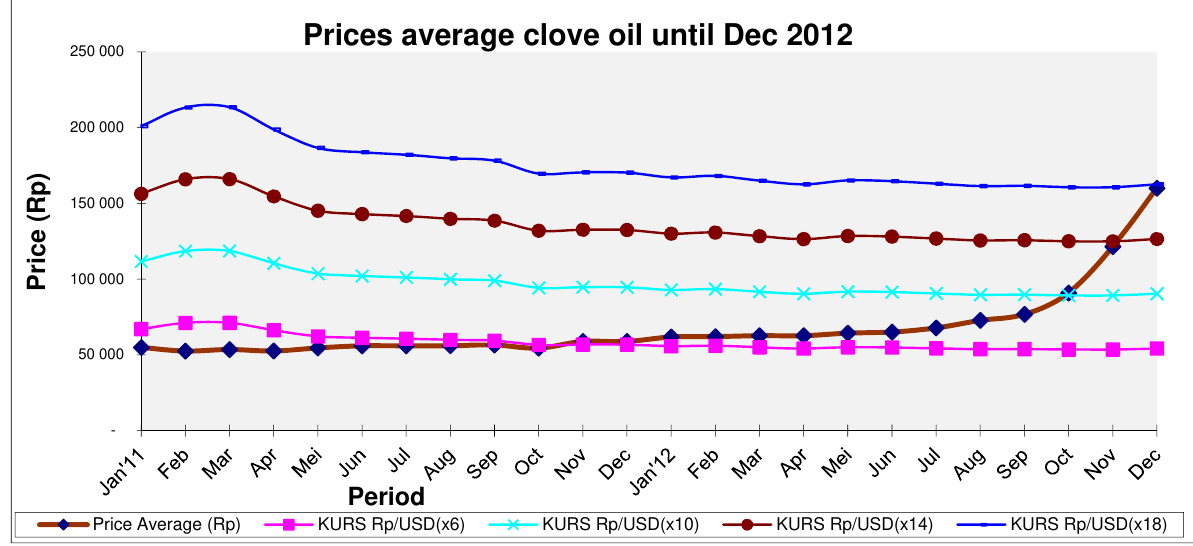
Fig. 2. Average price of purchase until December 2012